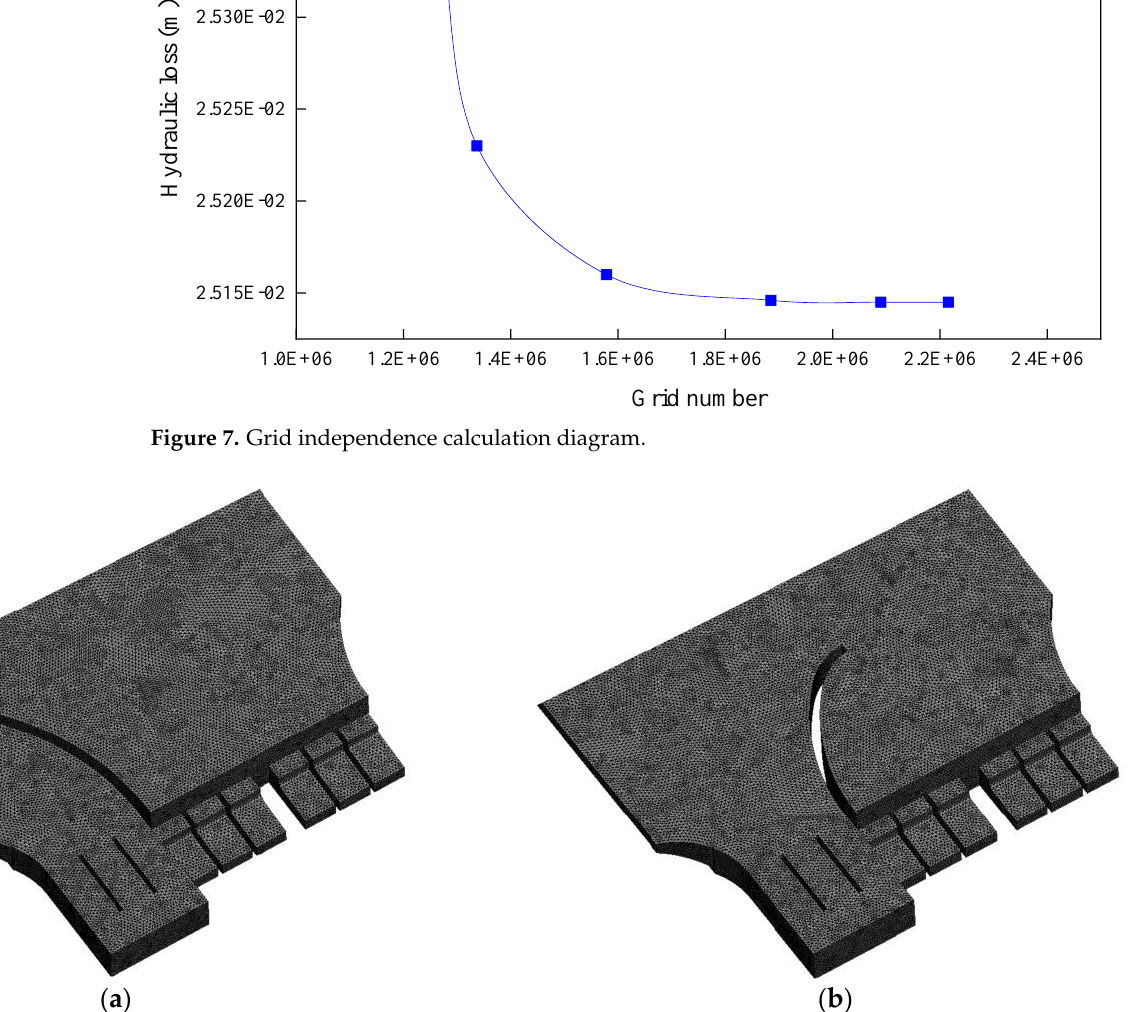
Figure 8. Schematic diagram of grid division in the inlet section of the calculation area: ( a ) Schematic diagram of grid division in the inlet section of the calculation area under pumping condition; ( b ) the grid of the inlet section of the calculation area under free-draining condition.